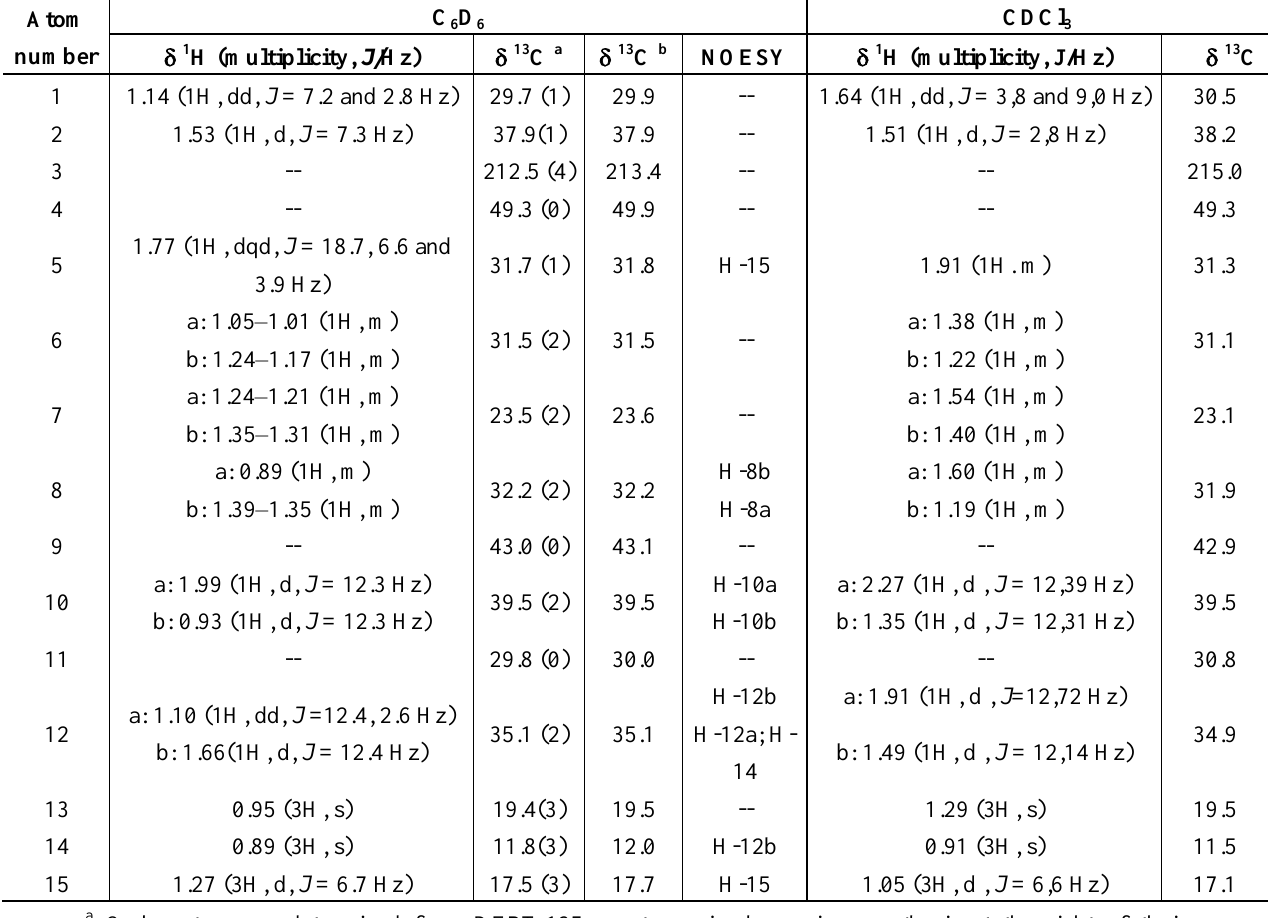
D and CDCl 6 6 3